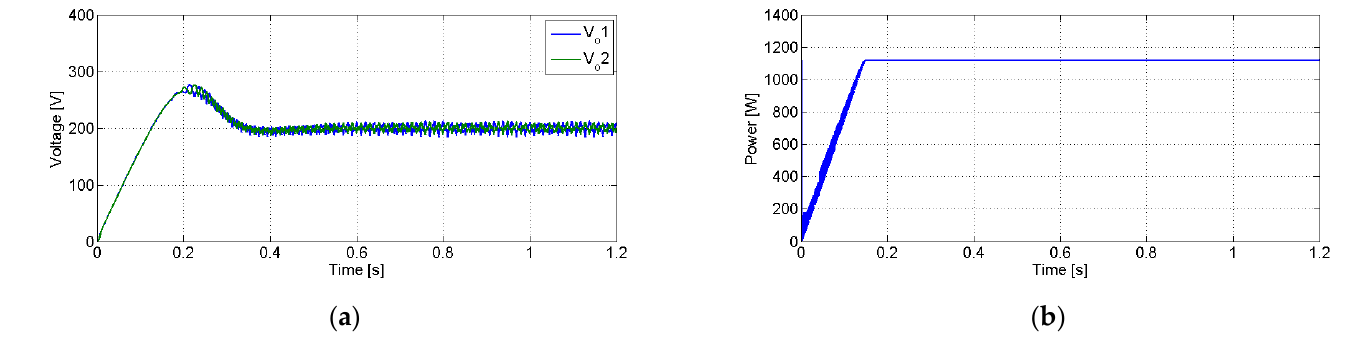
Figure 8. Obtained simulation waveforms during the connection of the system (transient operation): ( a ) DC/DC output voltages, ( b ) generated PV power.